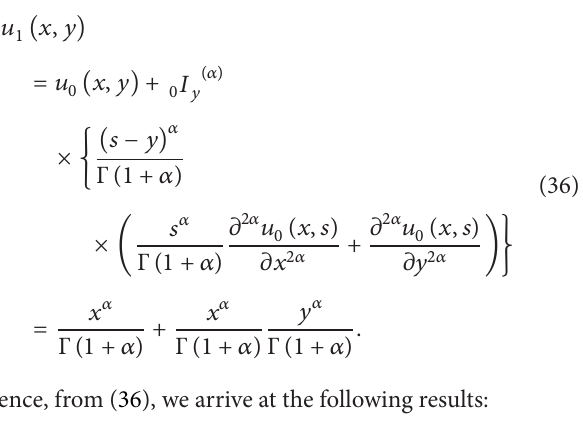
which is the local fractional divergent series. Therefore, we can obtain the approximate solution.